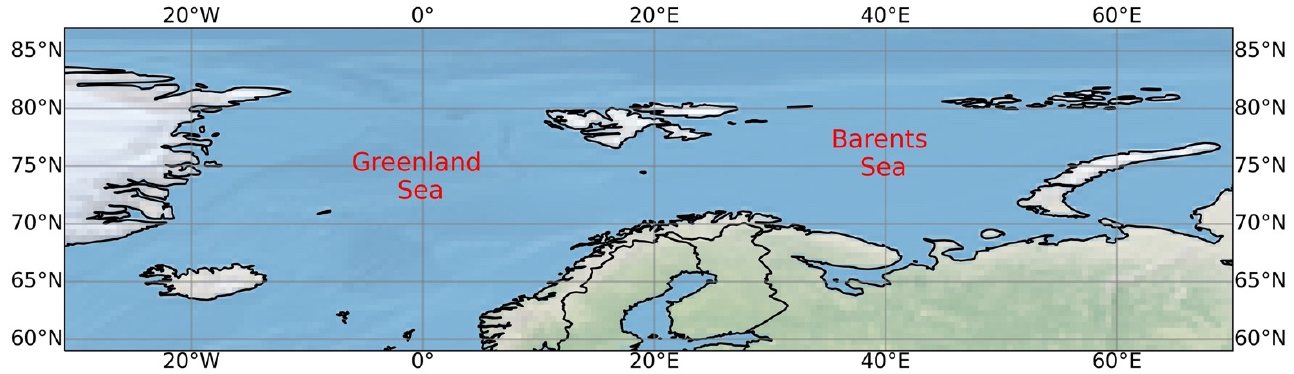
Figure 1. Map of the European Arctic and its adjacent seas.